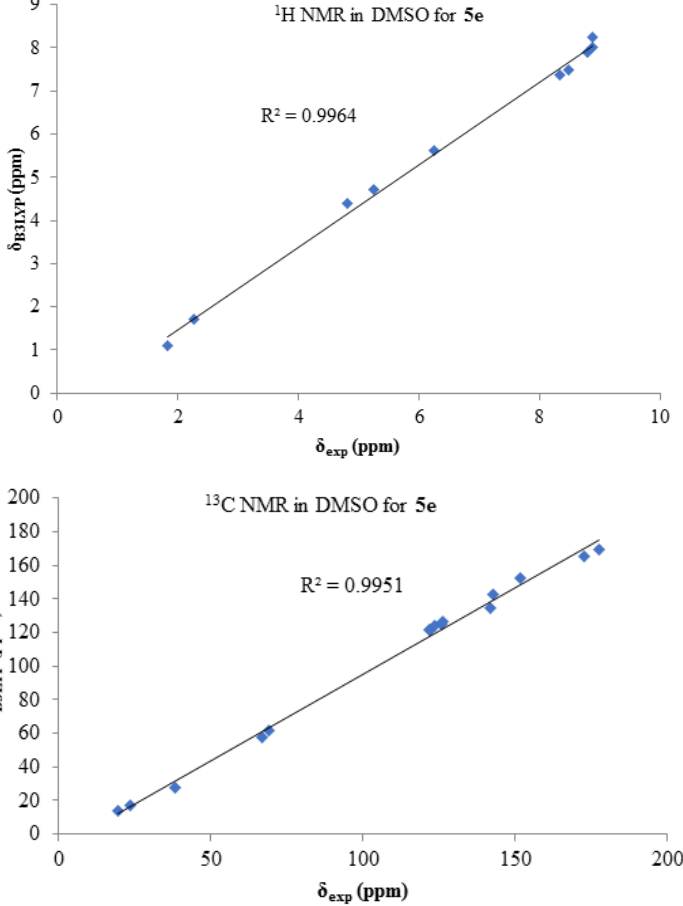
Figure 2. 1 H and 13 C chemical shifts’ correlation between calculated and experimental data for 5e in DMSO.